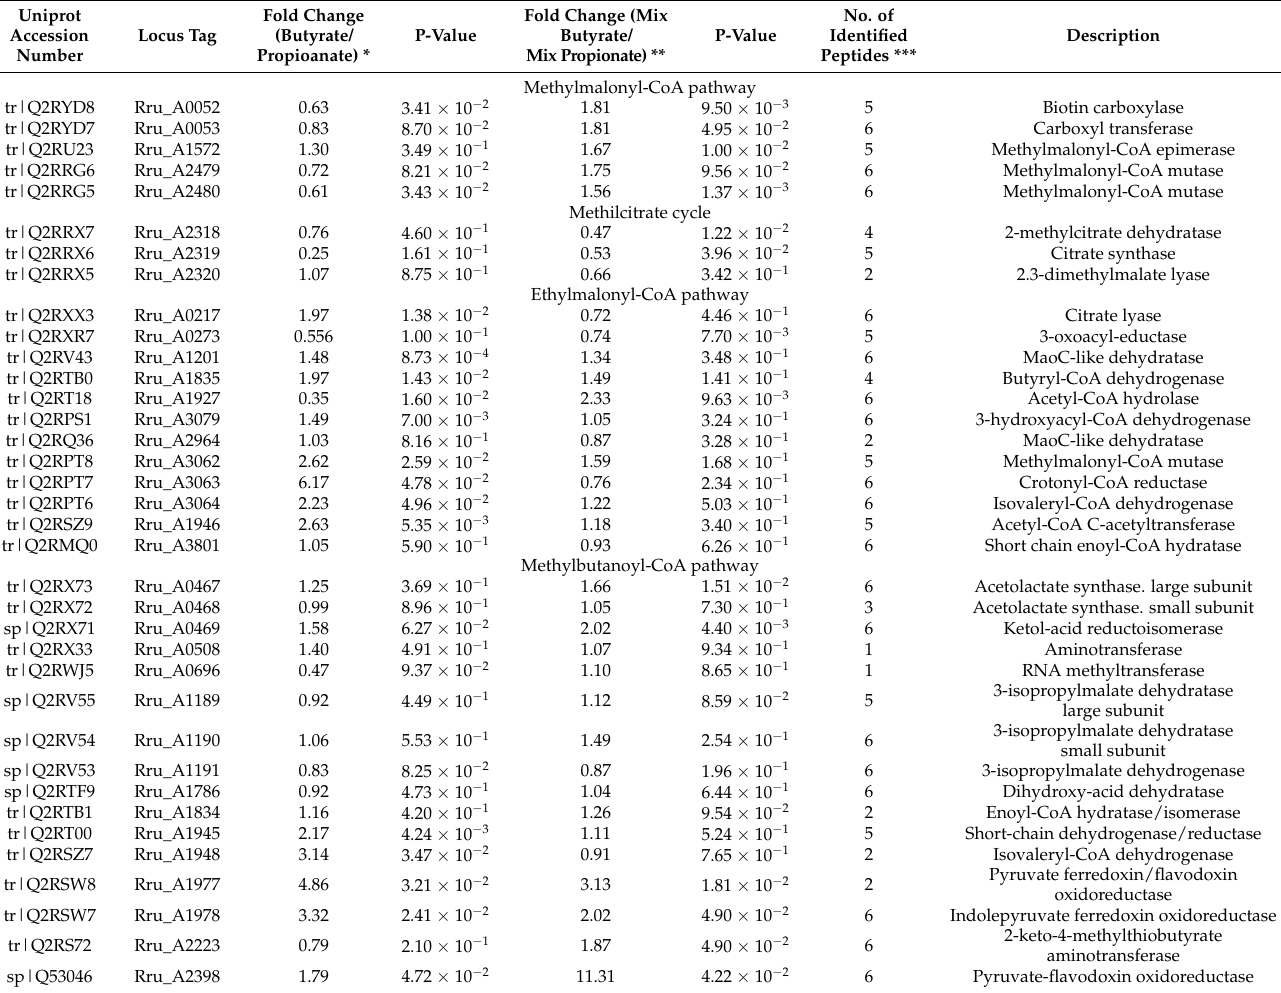
Table 1. Differential expression of proteins in Rhodospirillum rubrum cultivate with propionate, butyrate, or a mixture of both. * The fold change is the ratio of the abundance of a protein under butyrate conditions to the abundance under propionate conditions. ** The fold change corresponds to the ratio of the abundance of a protein during the assimilation phase of butyrate and its abundance during the propionate assimilation phase under mixture conditions. *** No. of identified peptides represents the number of peptides used for